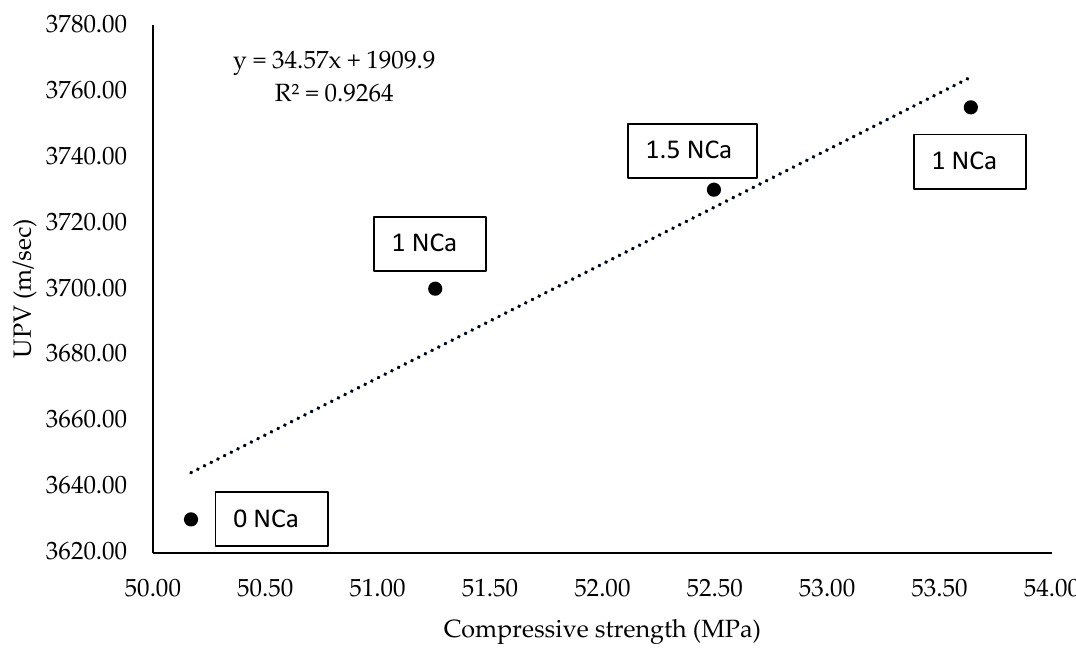
Figure 9. Correlation between compressive strength and UPV.